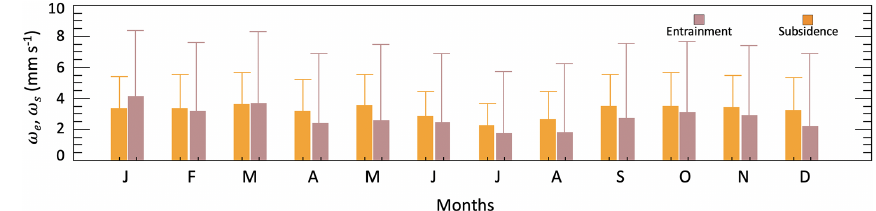
Figure 4. Monthly entrainment rates ω e and subsidence rates ω s with associated 1 standard deviation.